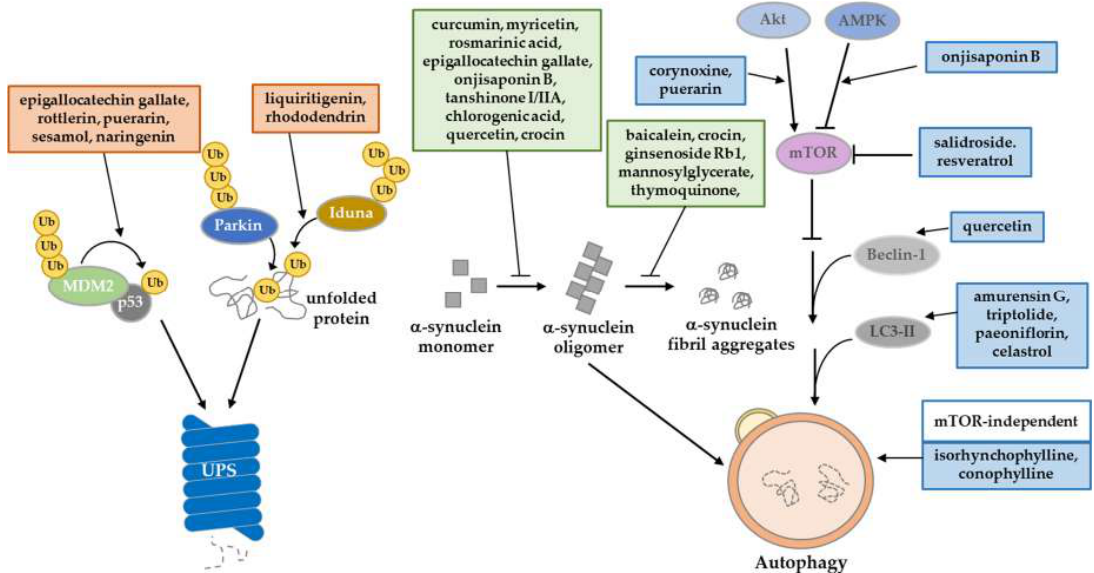
Figure 2. Summary of natural product regulation in proteostasis machinery. Natural products have a potential role to play in the amelioration of PD-induced proteostasis impairment. They regulate UPS through E3 ligase activity, increasing the autophagy-lysosome pathway, and inhibiting the posttranslational modifications of α-synuclein.